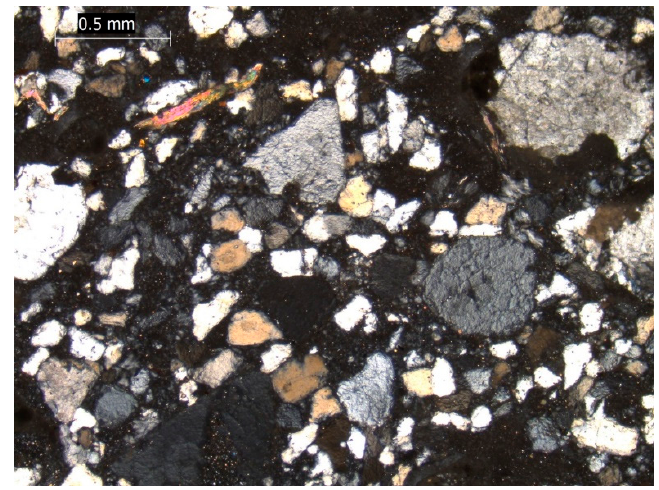
Figure 8. Thin section from a Disi Sandstone specimen from Beidha. Notable in it are relatively angular and poorly sorted quartz grains and a well-preserved mica particle in the upper left corner. XPL.